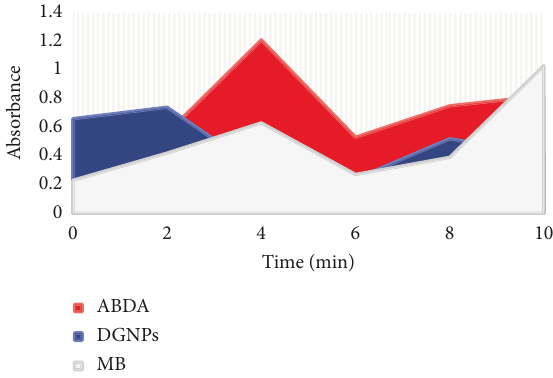
Figure 3: Photodegradation curve of